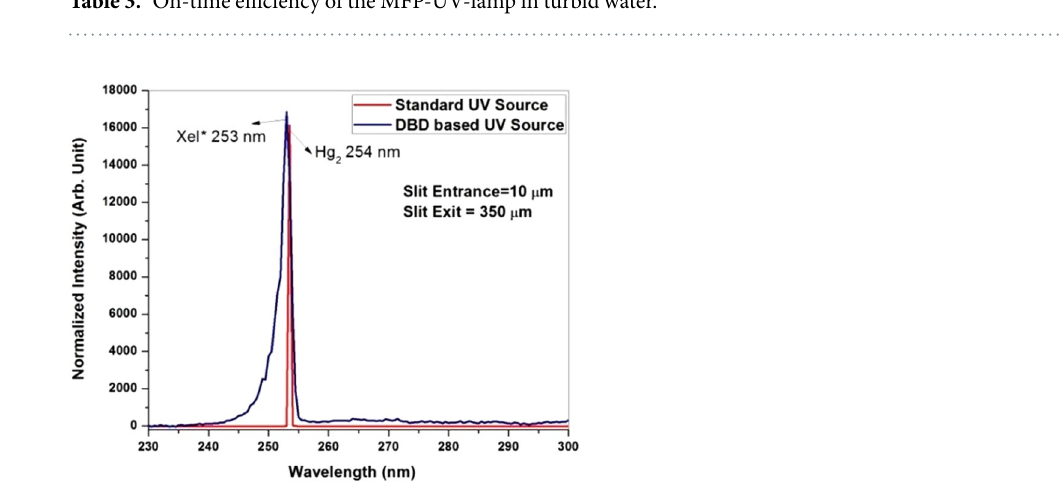
Table 3. On-time efficiency of the MFP-UV-lamp in turbid water.